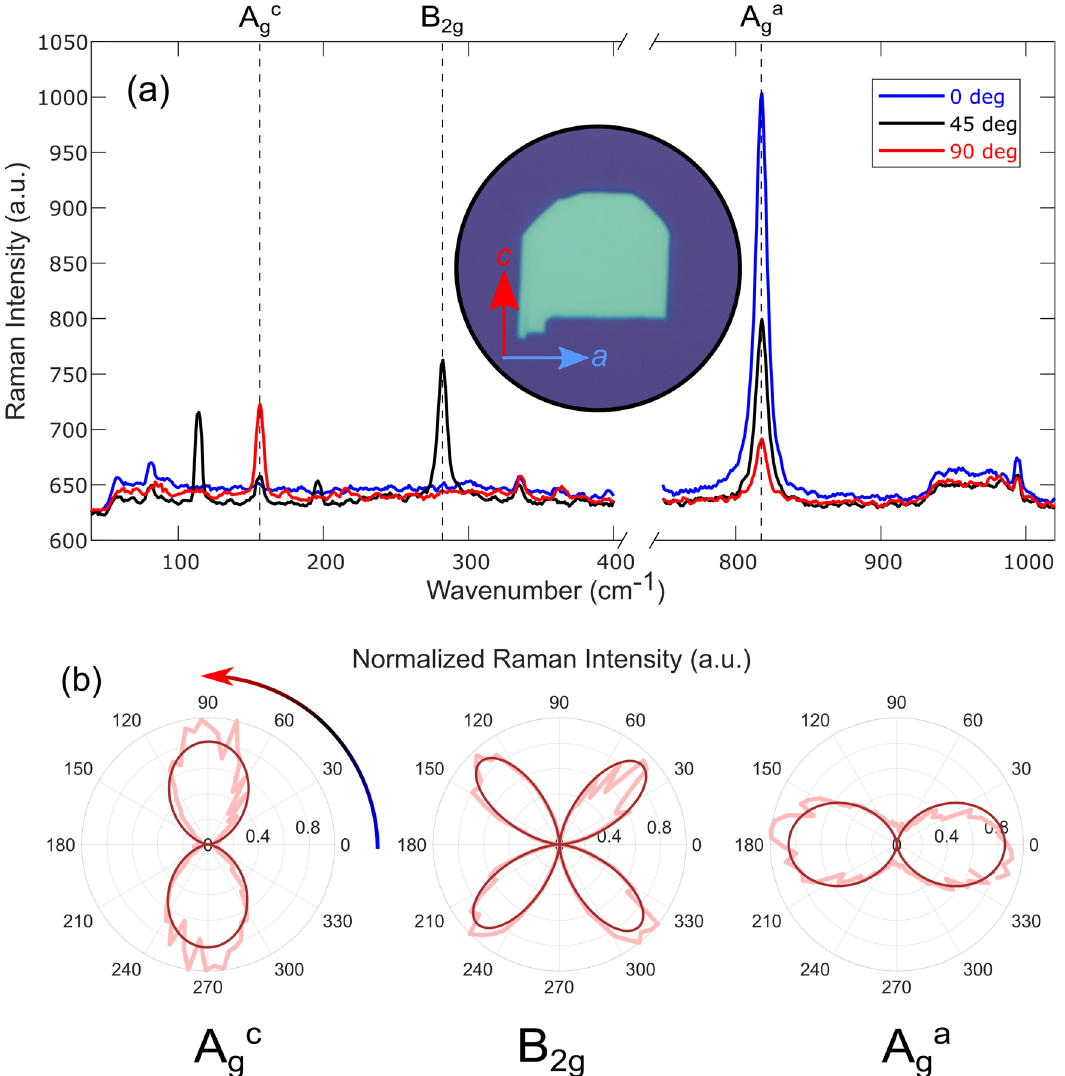
Fig. 2 Determining the crystal orientation of MoO 3 through Raman spectroscopy. a Raman spectra at 0° (blue), 45° (black) and 90° (red) angles with respect to the horizontal axis. A gc , B 2g and A ga Raman modes are highlighted with vertical dashed lines. Inset: Microscopy image of the sample placed in the initial position (0°) and the a and c axes, determined from the angle-resolved Raman measurements, are shown. b Polar plots, in light red; and fi ttings, in dark red, of angle-resolved normalized Raman intensities of the A gc (left), B 2g (middle) and A ga (right)